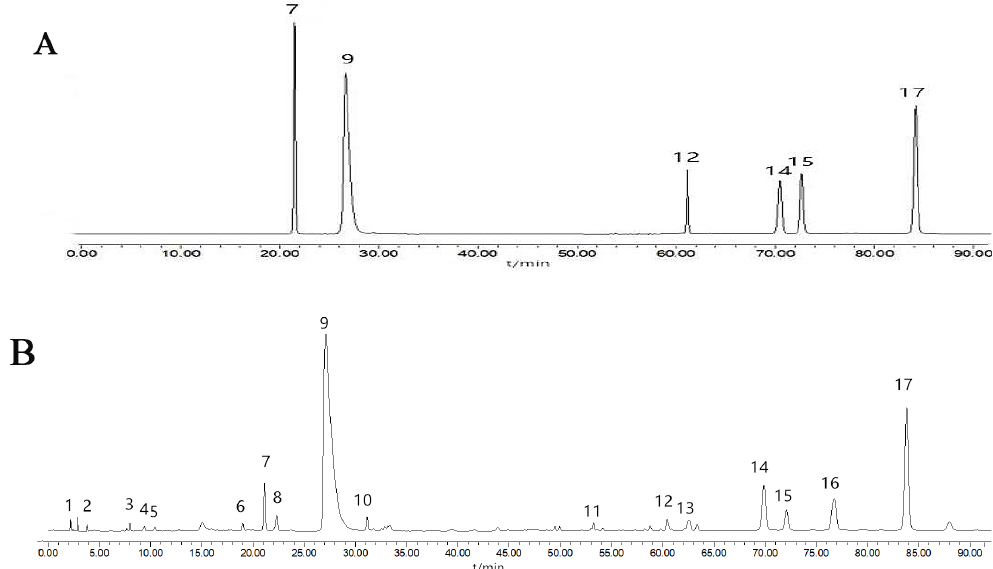
Figure 5. Typical chromatograms of standard mixed solution ( A ) and samples ( B ). 7-rosmarinic acid; 9-salvianolic acid B; 12-dihydrotanshinone I; 14-cryptotanshinone; 15-tanshinone I; 17-tanshinone IIA.